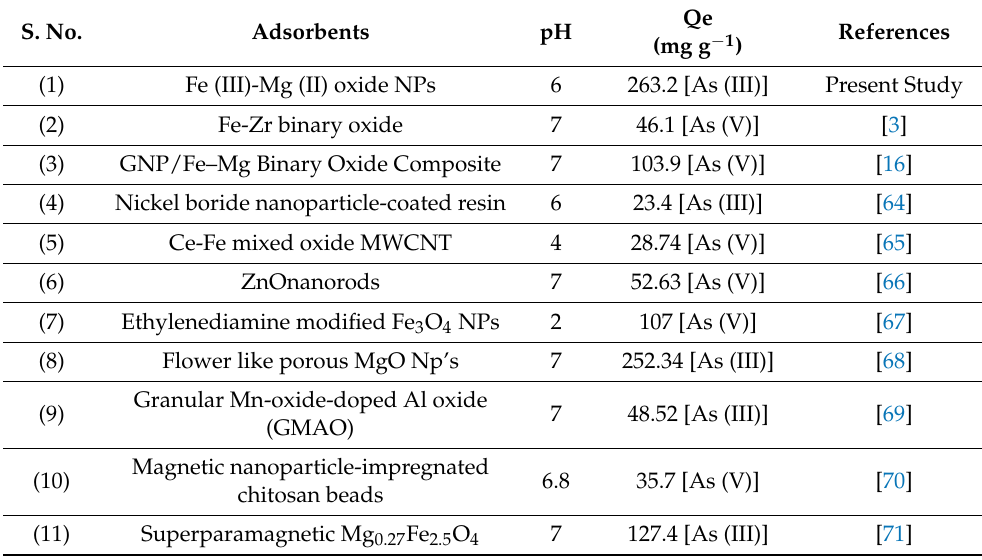
Table 2. Arsenic adsorption capacities of few recently used nano-sized adsorbents as reported.